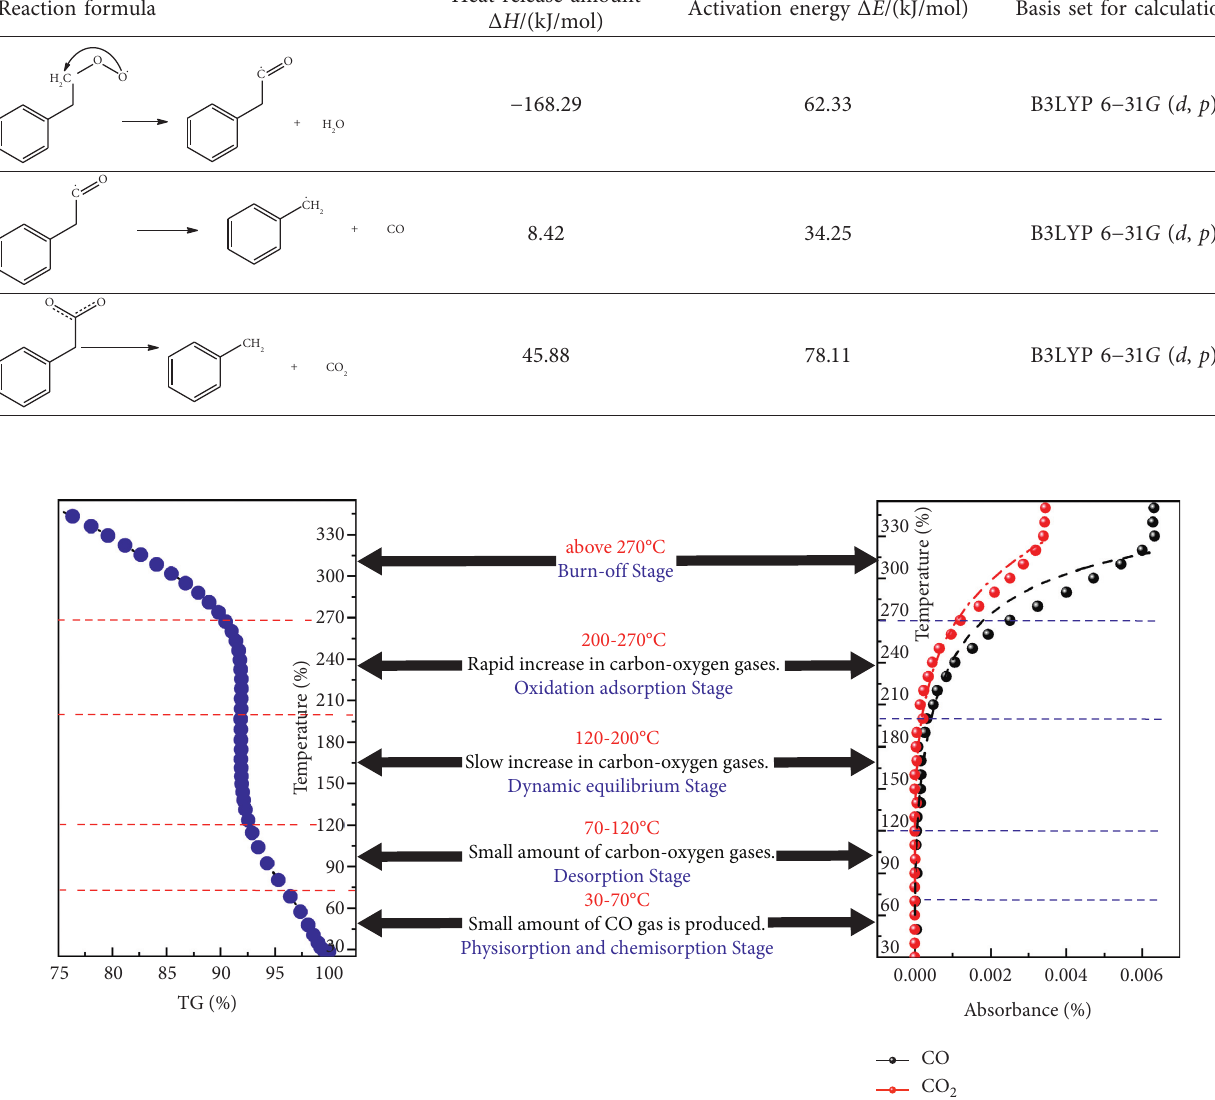
Table 5: Thermodynamics data of key chemical reactions after coal oxygen chemisorption. Reaction formula